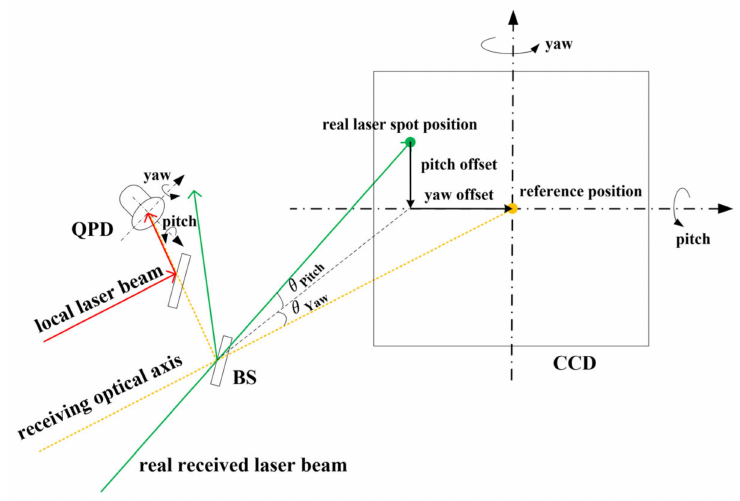
Figure 4. The two-stage acquisition strategy based on the CCD and QPD.